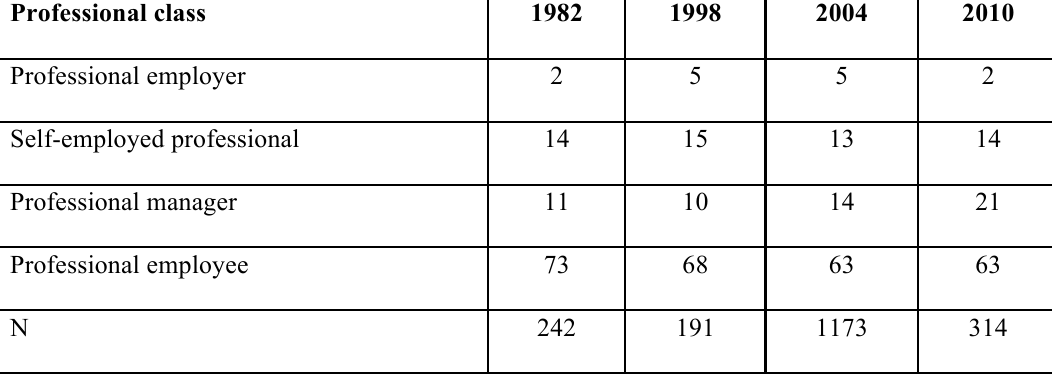
Distribution of professional classes, Canada, 1982-2010 (%) Professional class 1982 1998 2004 2010 Professional employer 2 5 5 2 Self-employed professional 14 15